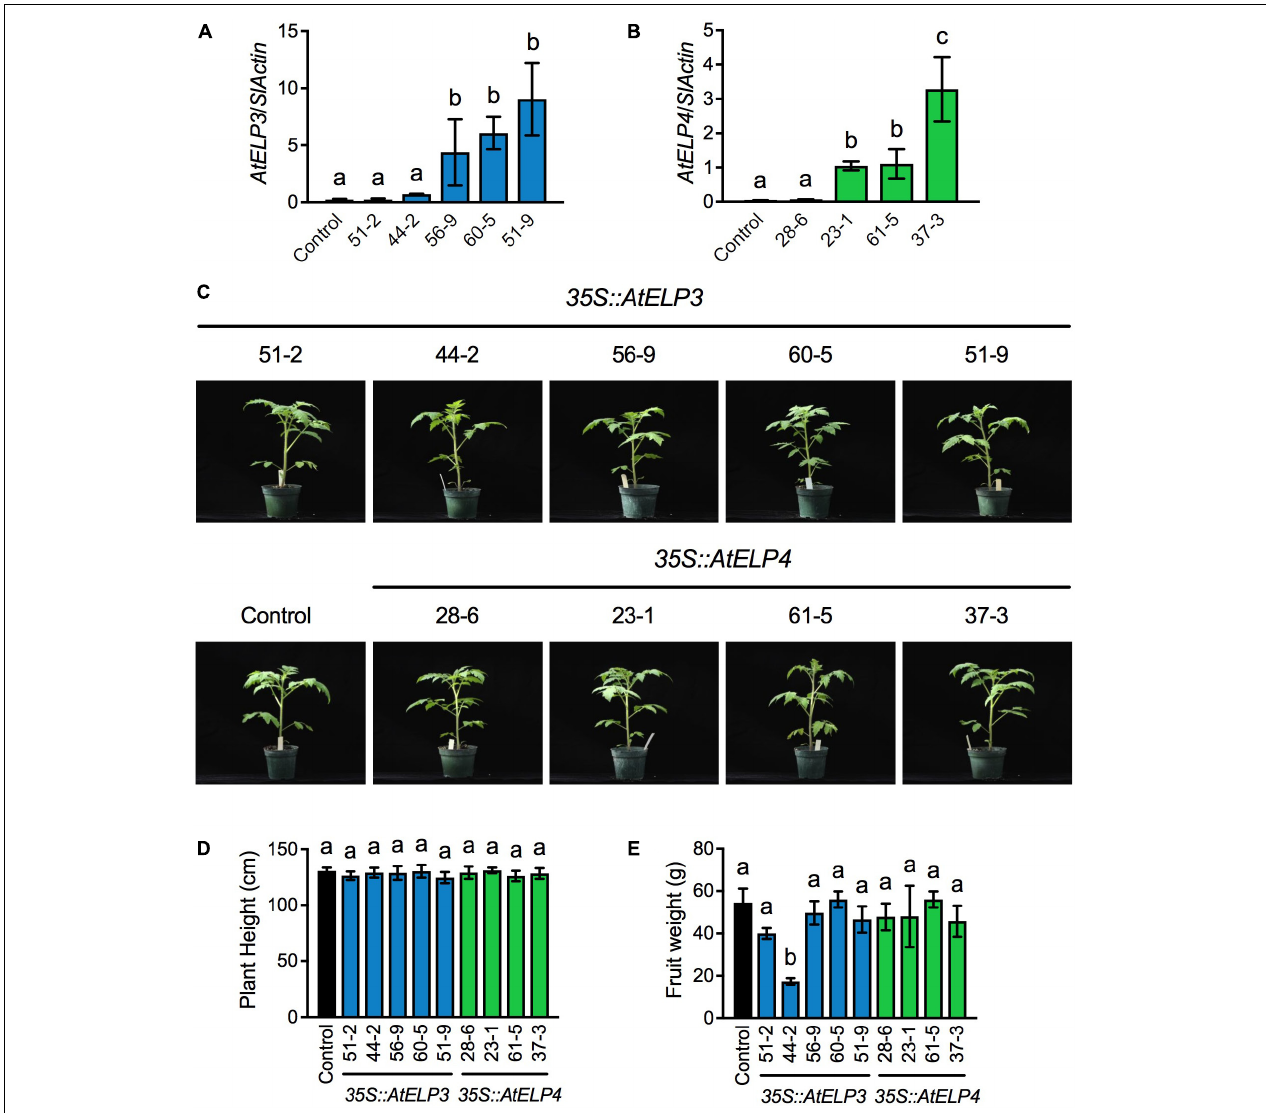
FIGURE 1 | Molecular and morphological characterization of transgenic tomato lines expressing AtELP3 and AtELP4 . (A,B) Expression levels of AtELP3 (A) and AtELP4 (B) in independent AtELP3 and AtELP4 transgenic lines, respectively. Expression of the transgene was normalized against the constitutively expressed SlActin gene. Almost no AtELP3 and AtELP4 expression was detected in the non-transformed control. Data represent the mean of three biological replicates with SD. Different letters above the bars indicate significant differences (Tukey’s test, P < 0.05). (C) Morphological phenotypes of the transgenic tomato lines and the control. Photos were taken 30 days after germination. (D) Plant height of the transgenic lines and the control. Data represent the average of six plants with SD. Different letters above the bars indicate significant differences (Tukey’s test, P < 0.05). (E) Fruit weight of the transgenic lines and the control. Data represent the average weight of fruit from six plants with SD. Different letters above the bars indicate significant differences (Tukey’s test, P <